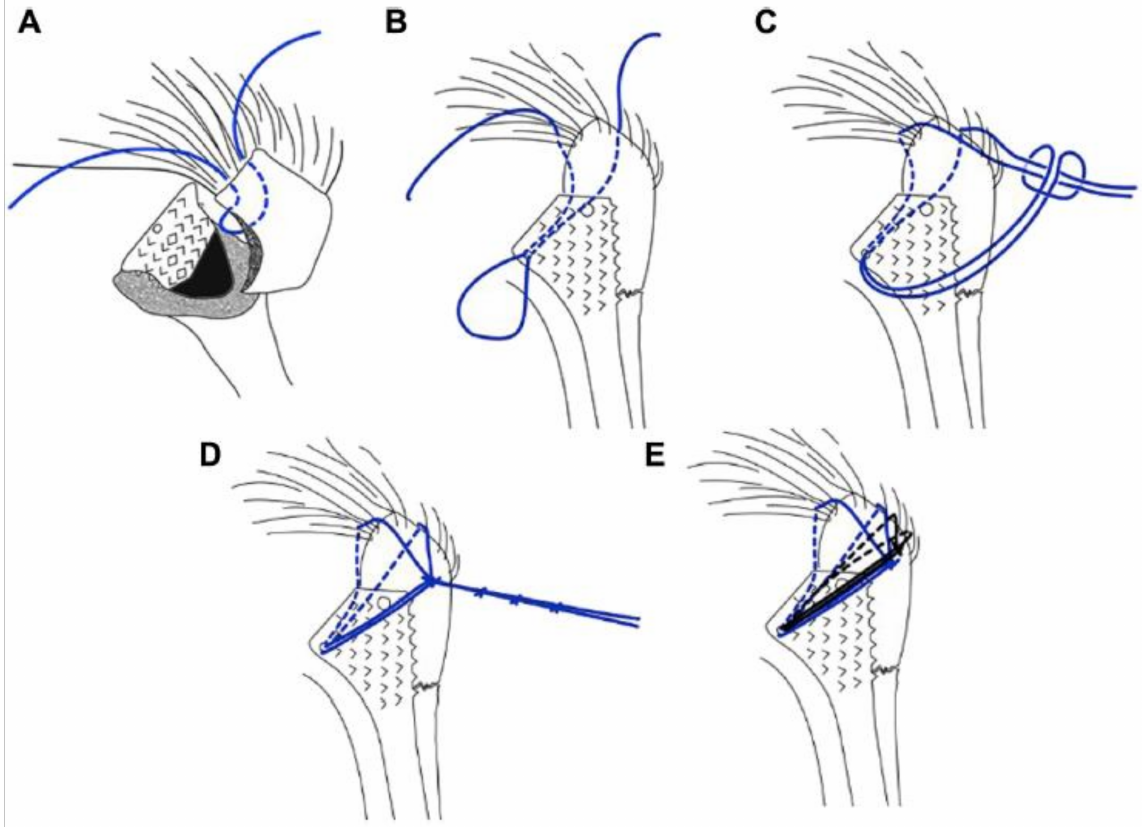
Figure 3. Illustration of the cow hitch technique. A suture loop is created intra-articularly at the tendon-bone interface of the in-fraspinatus ( A ). The loop is passed through the medial calcar hole of the prosthetic stem ( B ). Two loops are created by folding the loop twice ( C ) and the two free limbs are fed through the double loop ( D ), creating a self-locking mechanism. A second ‘cow hitch’ is thrown ( E ). Reprinted with permission from [74]. Copyright 2021.